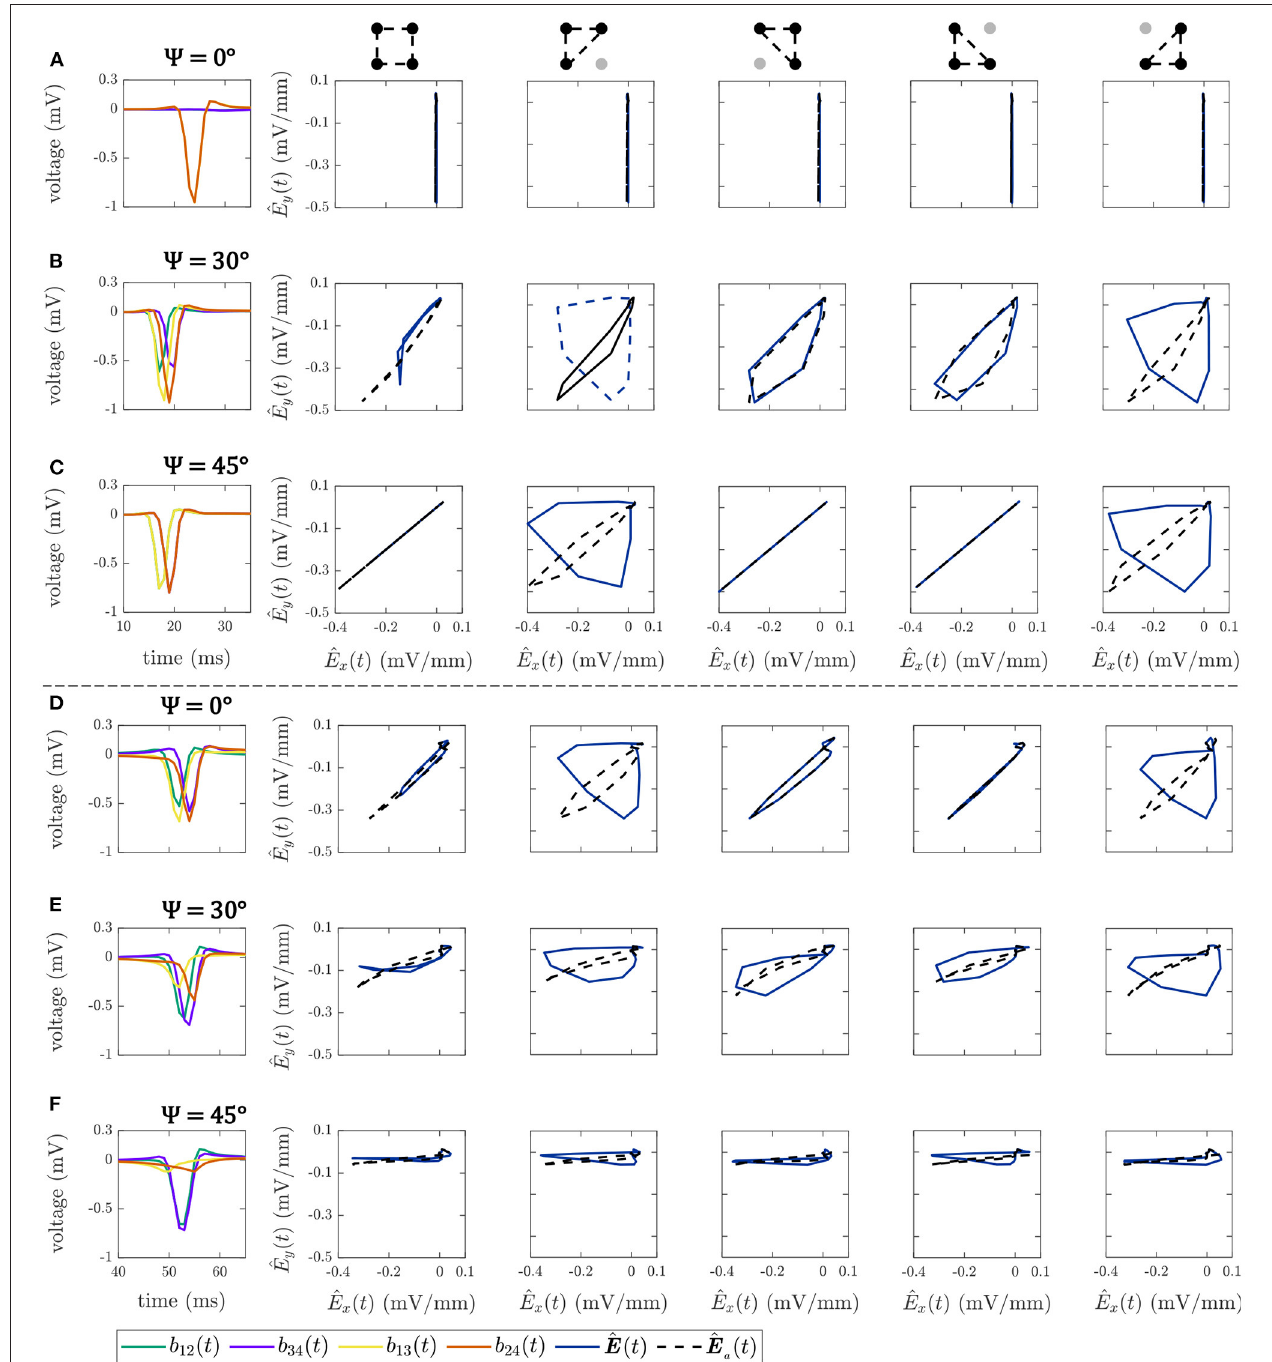
FIGURE 5 | Bipolar EGMs (first column) and E-field loops (remaining columns) obtained with (dashed line) and without (solid line) the alignment of b-EGMs, in square and triangular cliques. All the cliques represented are from non-fibrotic areas outside the fibrotic patch. Rows (A–C) : cliques with plane wavefront, when 9 = 0 ◦ , 9 = 30 ◦ and 9 = 45 ◦ , respectively. Rows (D–F) : cliques with curved wavefront, when 9 = 0 ◦ , 9 = 30 ◦ and 9 = 45 ◦ , respectively.